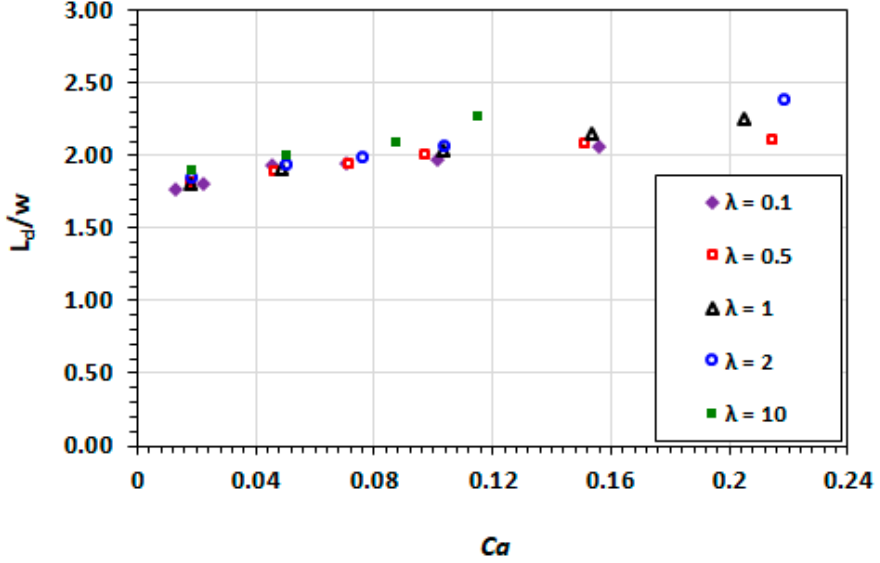
Figure 10. Dependence of the non-dimensionalised droplet length on capillary number at varying viscosity ratios.